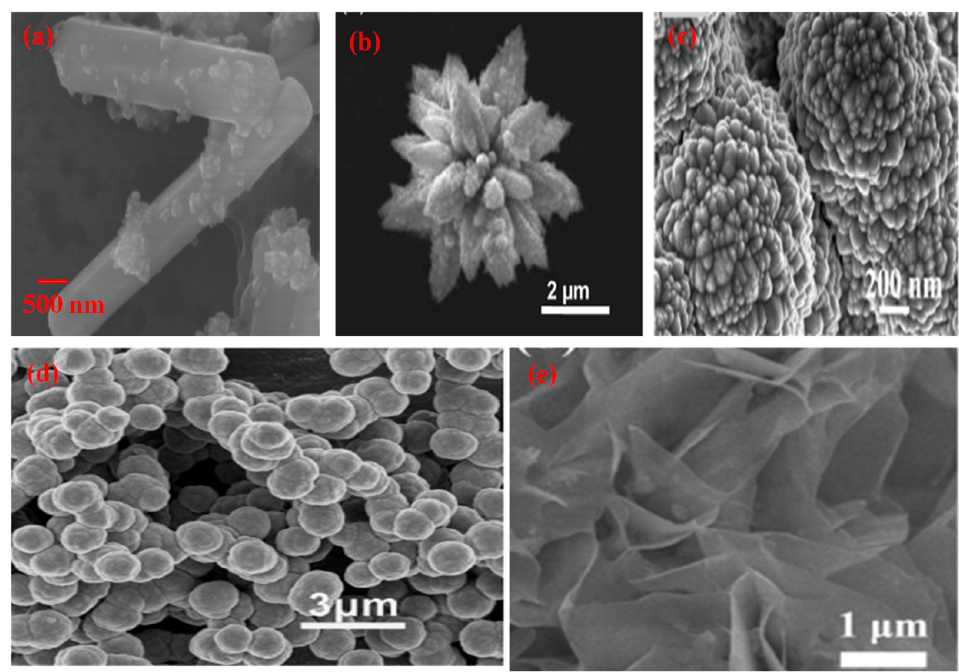
Figure 5. SEM micrographs of different morphologies of CdS ( a ) Nanorod (Reprinted with permis- sion from [99]. Copyright 2018 Elsevier), ( b ) Nanoflower (Reprinted with permission from [100]. Copyright 2017 Elsevier), ( c ) Particles (Reprinted with permission from [101]. Copyright 2019 Else- vier), ( d ) Nanosphere (Reprinted with permission from [102]. Copyright 2013 Elsevier), ( e ) Sheet (Reprinted with permission from [103]. Copyright 2018 Elsevier).